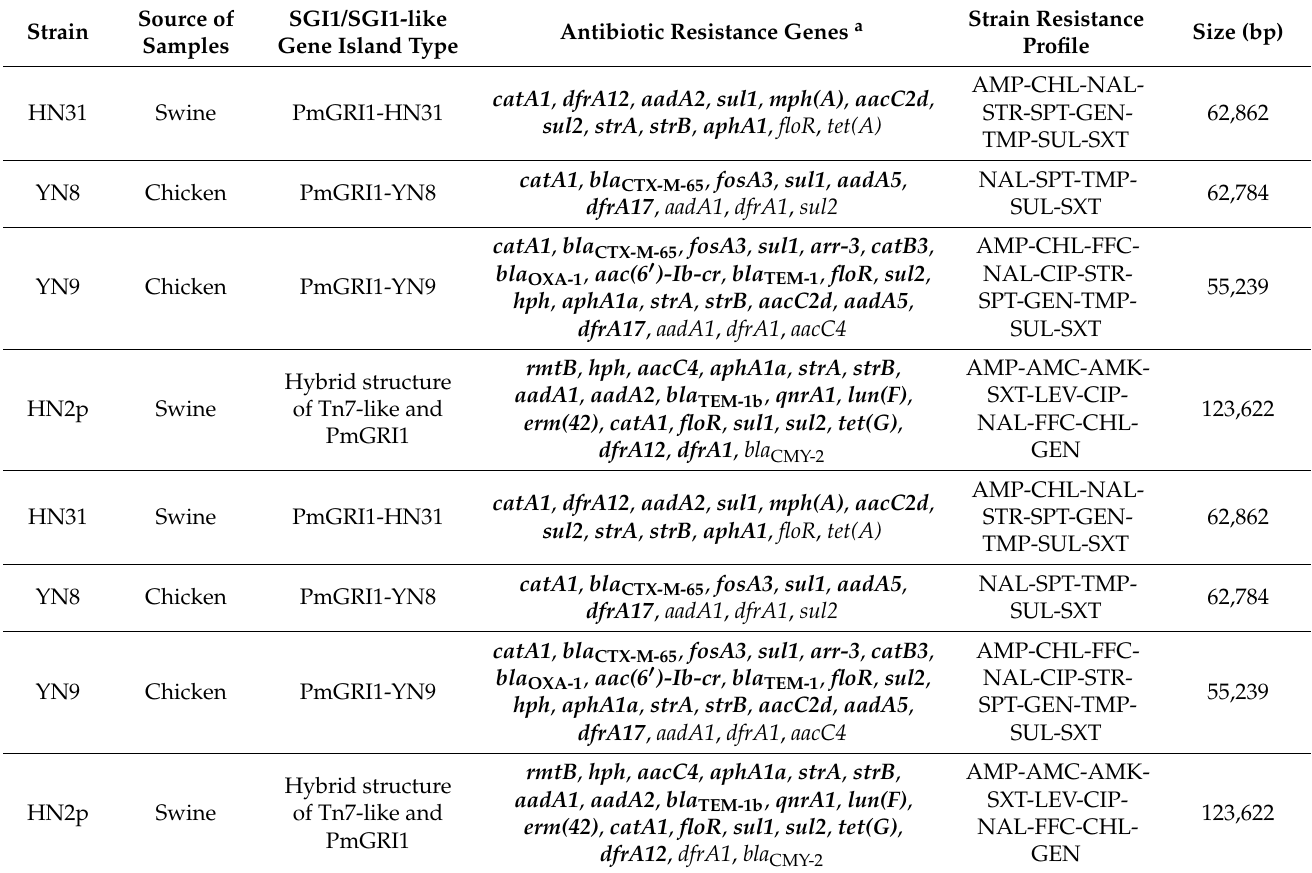
Table 1. Resistance genes and profile of PmGRI1 in P. mirabilis